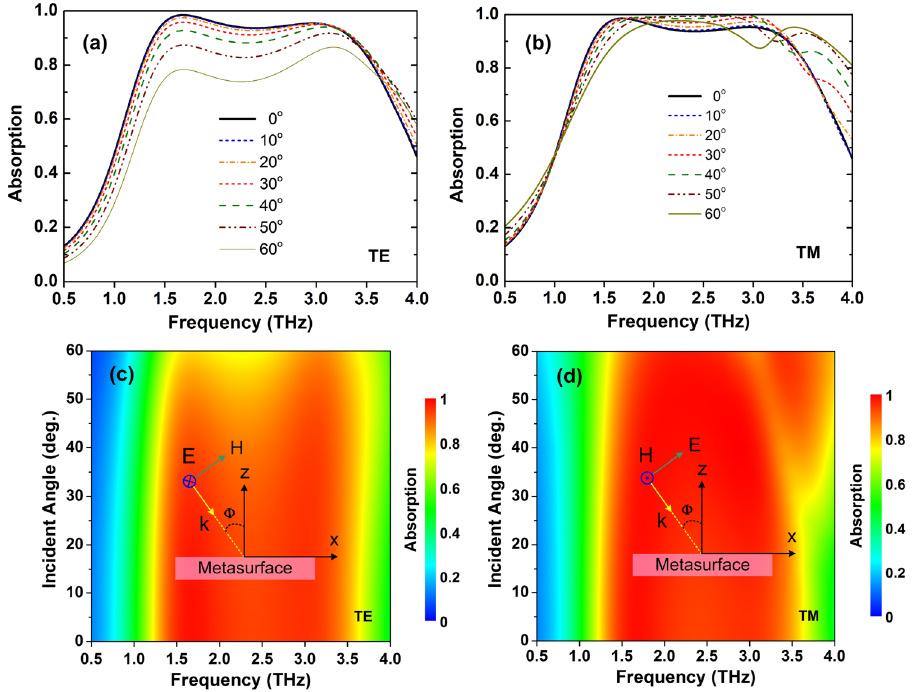
Figure 7. Dependence of absorption on incident angle ( (cid:31) ) of the proposed RMS for ABS mode under ( a, c ) TE and ( b, d ) TM polarizations.